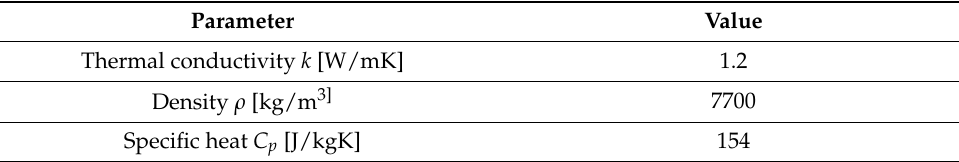
Table 1. TEG module